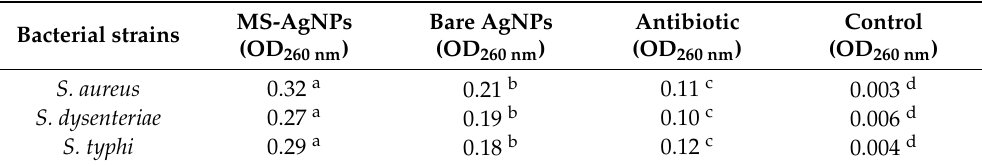
Table 3. OD at 280 nm of the cell constituent (periplasmic proteins) release from the selected bacterial strains upon treatment with MS-AgNPs, bare AgNPs, antibiotic, and control. MS-AgNPs Bare AgNPs Antibiotic Control Bacterial strains (OD 260 nm ) (OD 260 nm ) (OD 260 nm ) (OD 260 nm ) 0.32